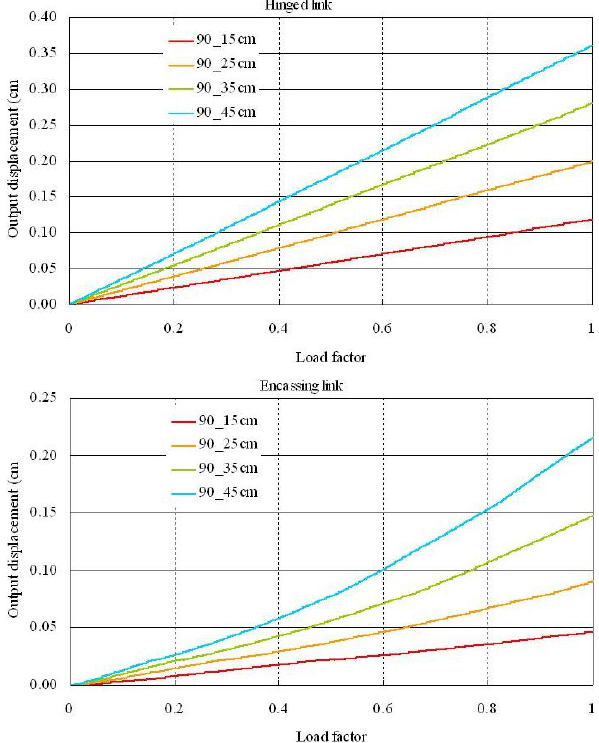
Fig. 4. Output displacement at the left column top for vertical load- ing (90 ◦ ) with different magnitudes: (a) hinged structure; (b) en- casing